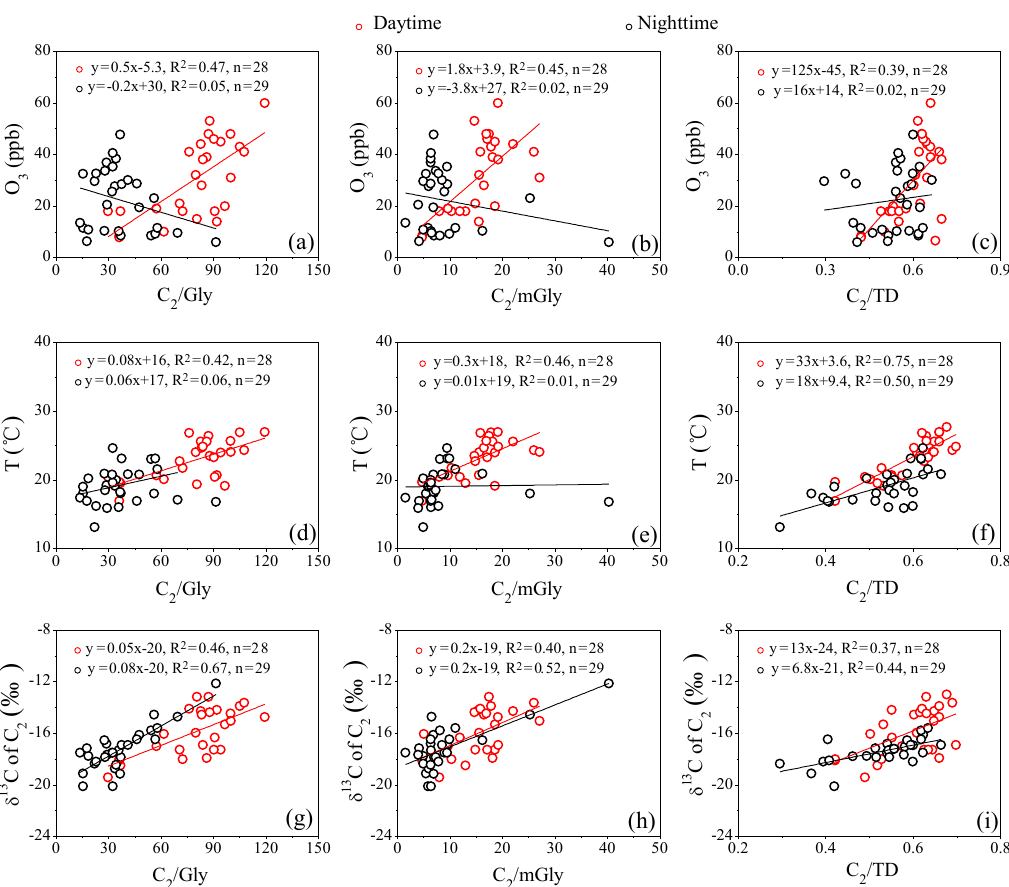
Figure 8. Correlation analysis for the mass ratios of C 2 / Gly, C 2 / mGly and C 2 / TD with (a–c) concentrations of O 3 ; (d–f) temperature and (g–i) δ 13 C of C 2 during the daytime and nighttime (C 2 / TD: mass ratio of oxalic acid to total dicarboxylic acids; T : temperature).